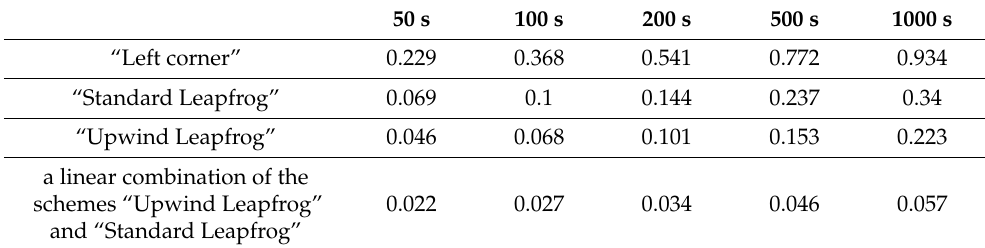
Table 2. Dependence of the error on solving the problem on time.